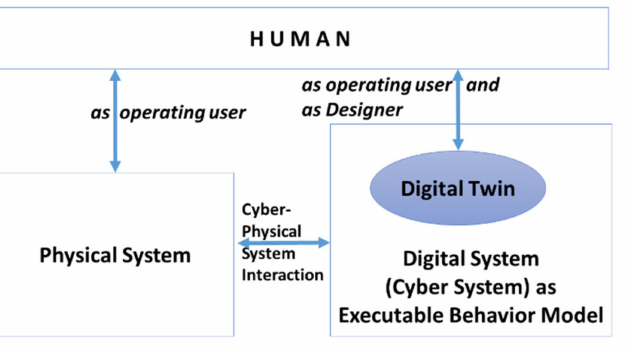
Figure 1. Cyber-Physical Systems as a socio-technical system with digital twin representation for functional operation and design-integrated